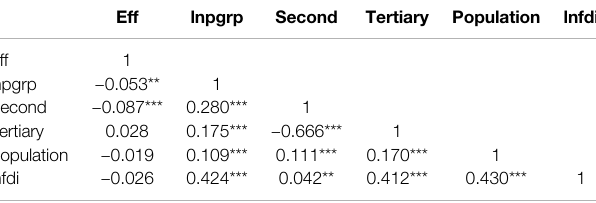
TABLE 3 | Pearson correlation coef fi cient matrix.